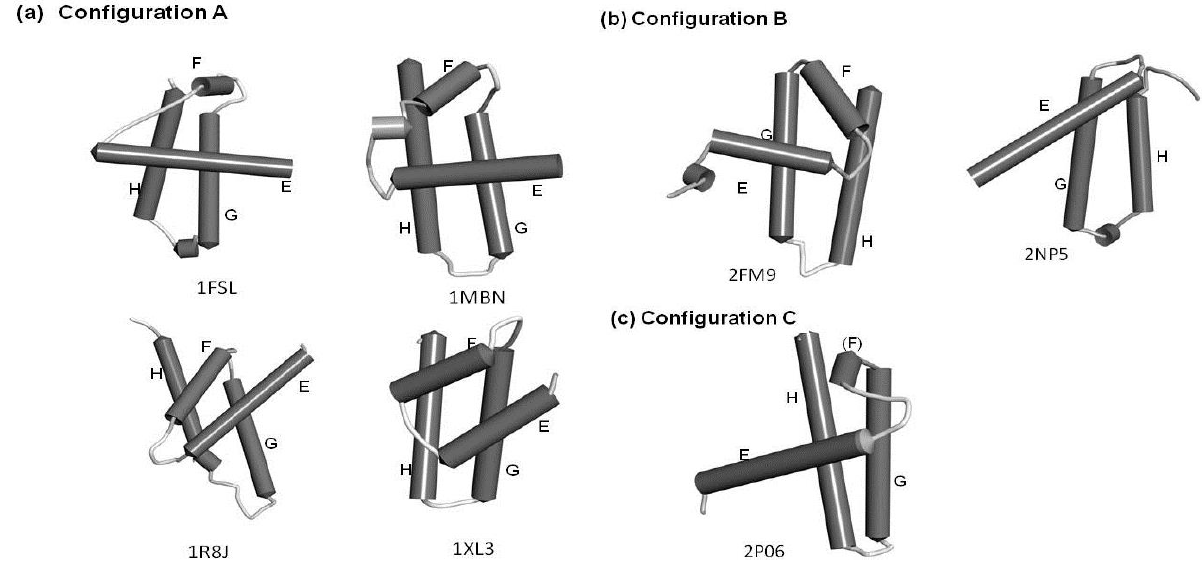
Figure 7. The configurations of helices E, F, G and H. ( a ) Configuration A. 1FSL, 1MBN, 1R8J and 1XL3 belong to this category. ( b ) Configuration B. Mirror image of configuration A. 2FM9 and 2NP5 belong to this category. ( c ) Configuration C. Variant of Configuration A. 2P06 belongs to this